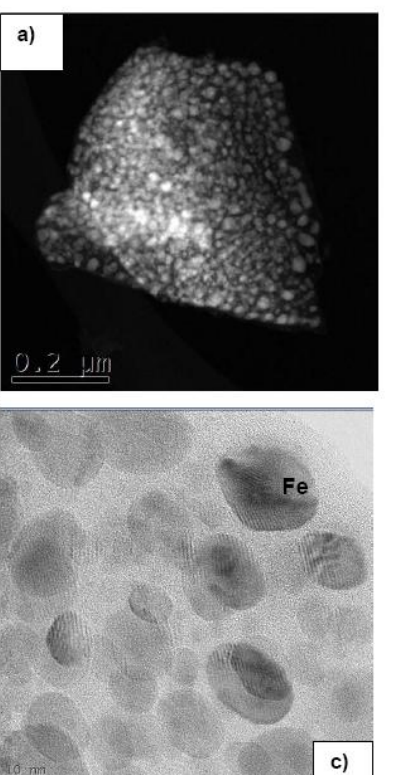
Figure 10. STEM images showing the microstructure of individual 2Mg-Fe powder particle obtained from the decomposition of Mg Annular Dark Field detector) and (b) BF. (c,d) High resolution (HR) STEM bright field (BF) images showing the microstructure of 2Mg-Fe particle at lower and higher (lattice planes contrast) magnification. Adapted from